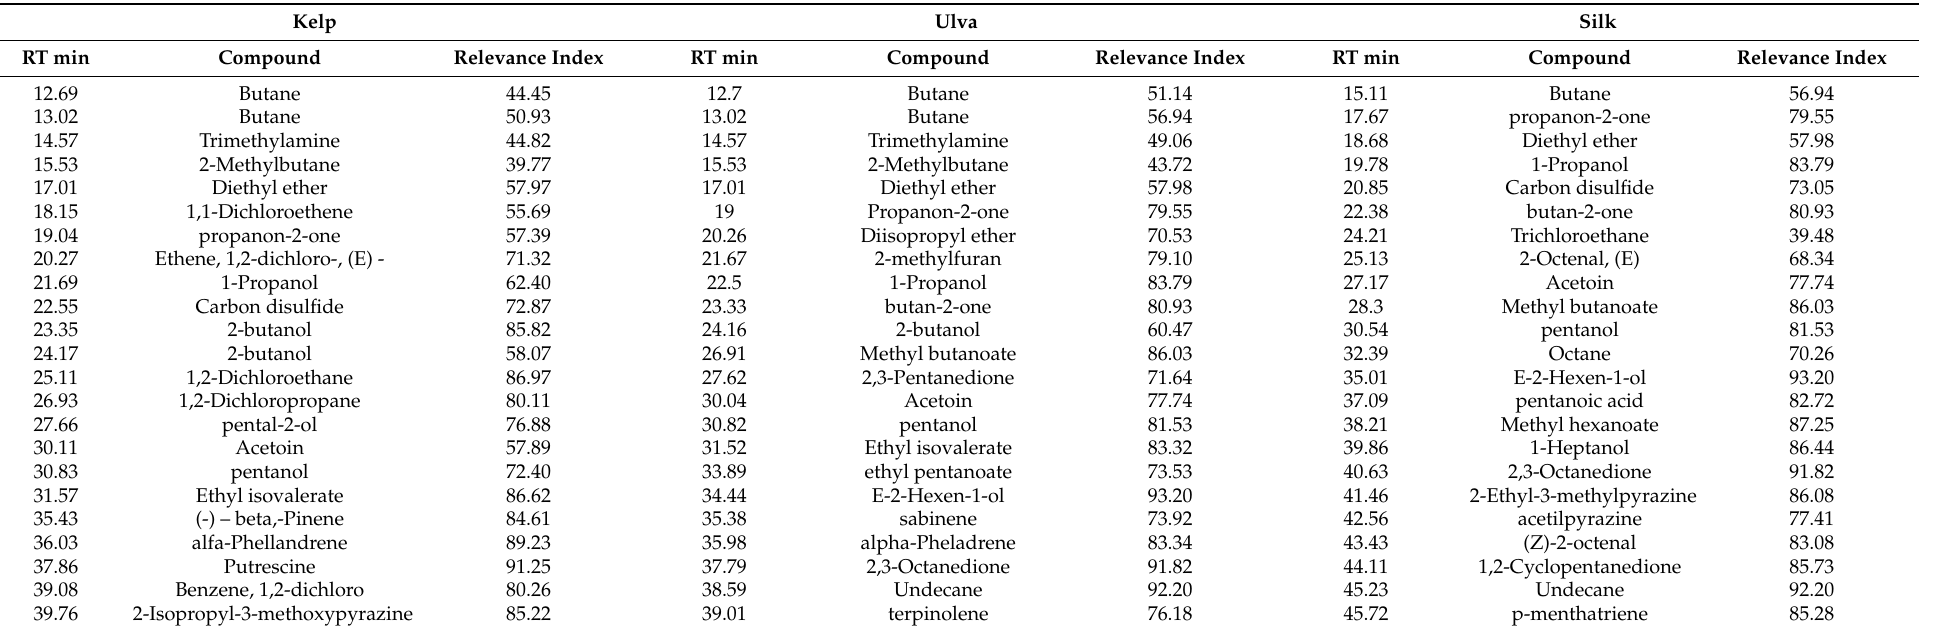
Table 1. Tentative identification of VOCs in Kelp, Ulva, and Silk algae by the FGC- E-Nose profile. Ulva